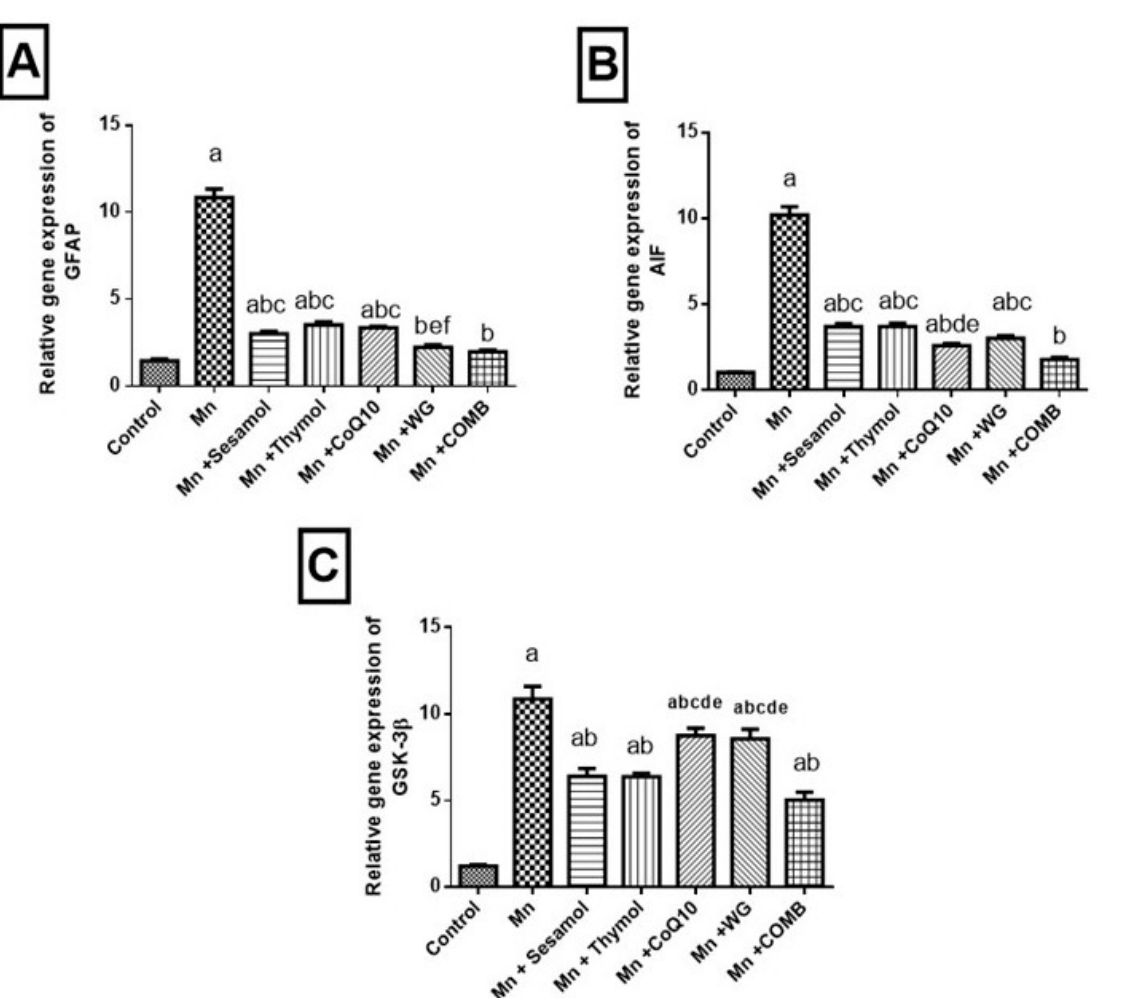
Figure 8. Effects of sesamol, thymol, CoQ10, wheat grass, or their combination on MnCl 2 -induced changes in mRNA expression levels of ( A ) Glial fibrillary acidic protein (GFAP), ( B ) apoptosis inducing factor (AIF), and ( C ) glycogen synthase kinase 3-beta (GSK-3 β ). Values are means of 6 rats ± S.E.M, as compared with control (a), Mn (b), COMB (c), sesamol (d), thymol (e), and CoQ10 (f) groups. One-way ANOVA with posttest Tukey’s multiple comparison assessed the statistical dif- ferences between the various groups, p -value < 0.05.